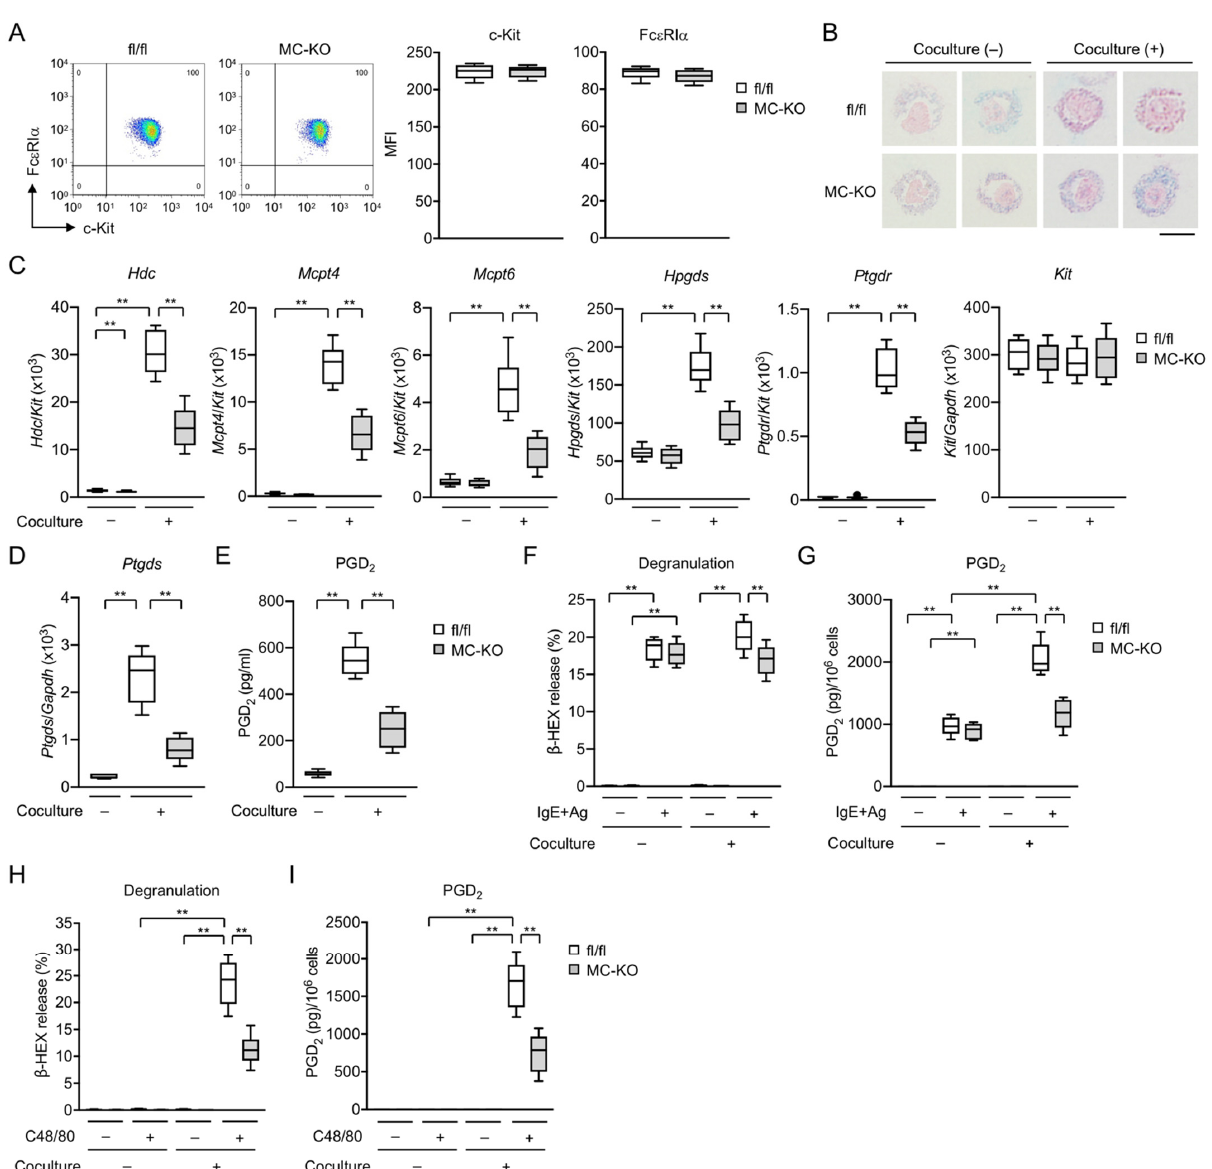
Figure 2. Defective fibroblast-directed maturation of MC-specific Pla2g3 -null BMMCs. ( A ) FACS analysis of Fc ε RI α (vertical axis) and c-Kit (horizontal axis) expression on the surface of BMMCs from Pla2g3 fl/fl (fl/fl) and Pla2g3 fl/fl Mcpt5 - Cre (MC-KO) mice. Representative FACS profiles and mean fluorescence intensities (MFI) of Fc ε RI α or c-Kit expression on the cell surface (n = 6) are shown. ( B ) Alcian blue/safranin staining of BMMCs with (+) or without ( − ) culture for 4 days with 3T3 fibroblasts. Scale bar, 5 µm. ( C ) mRNA expression levels for Hdc , Mcpt4 , Mcpt6 , Hpgds , Ptgdr , and Kit in Pla2g3 fl/fl and Pla2g3 fl/fl Mcpt5 - Cre BMMCs cultured with or without 3T3 fibroblasts (n = 6). ( D ) Ptgds mRNA levels and ( E ) PGD 2 production in 3T3 fibroblasts cultured with or without Pla2g3 fl/fl and Pla2g3 fl/fl Mcpt5 - Cre BMMCs (n = 6). ( F – I ) Pla2g3 fl/fl and Pla2g3 fl/fl Mcpt5 - Cre BMMCs cultured with or without 3T3 fibroblasts were sensitized with anti-DNP IgE and then stimulated with DNP-HSA (IgE + Ag), or activated directly with C48/80. Degranulation as assessed by β -HEX release ( F , H ) and PGD 2 production ( G , I ) were measured 10 min after MC activation (n = 6). Data are compiled from 2 experiments (box plots with Tukey whiskers; ** , p < 0.01).